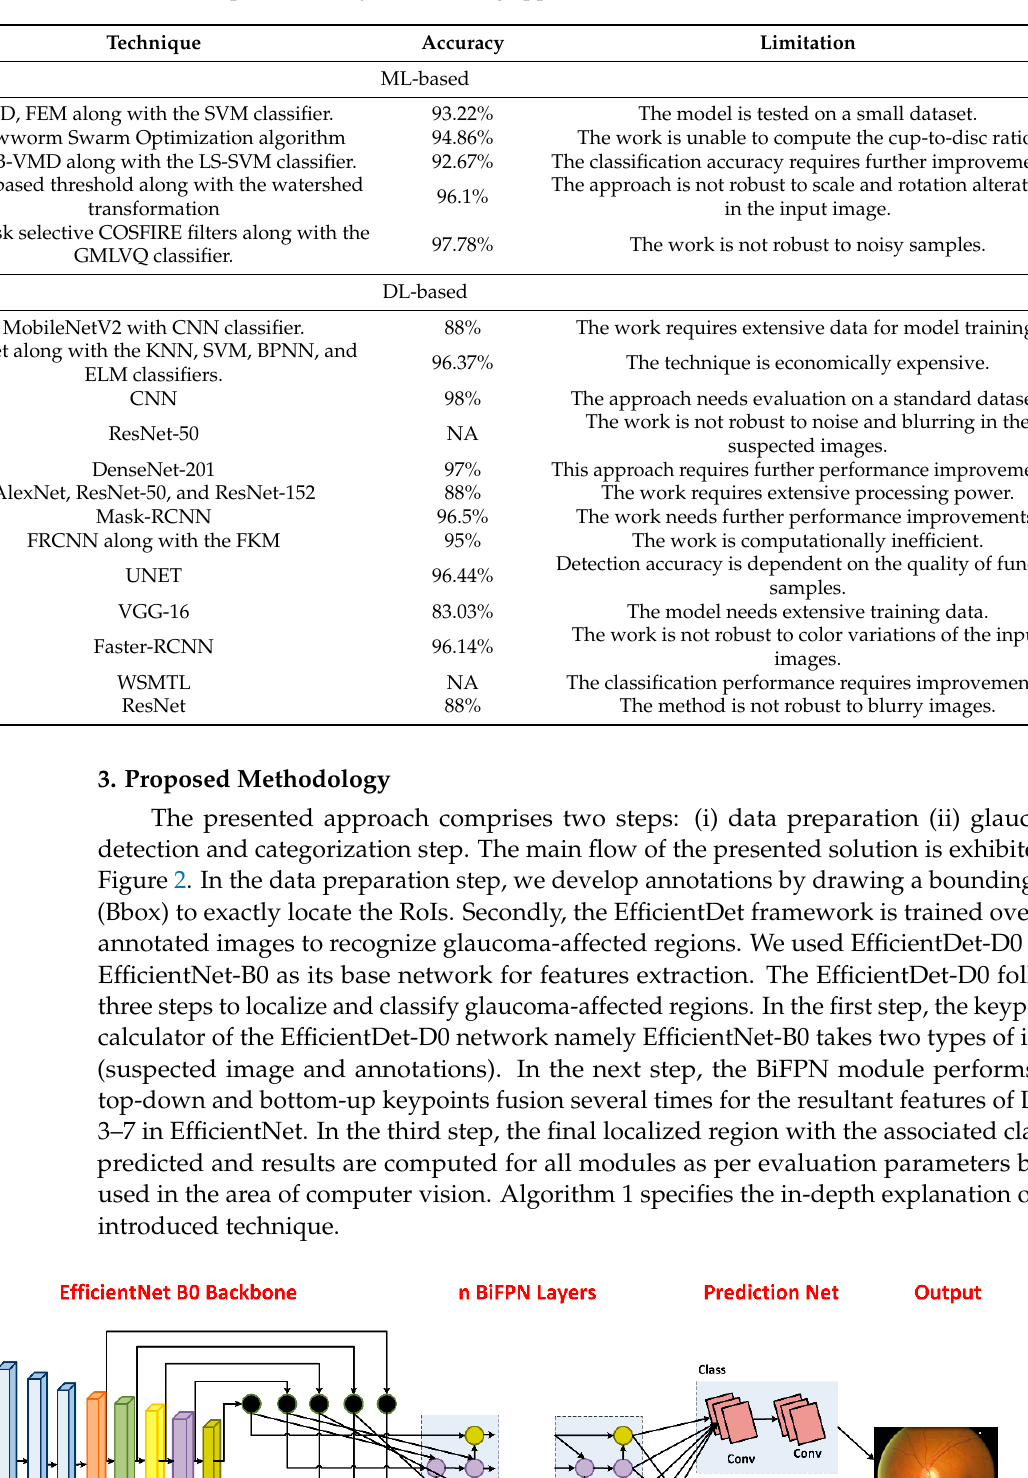
Table 1. Comparative analysis of existing approaches.